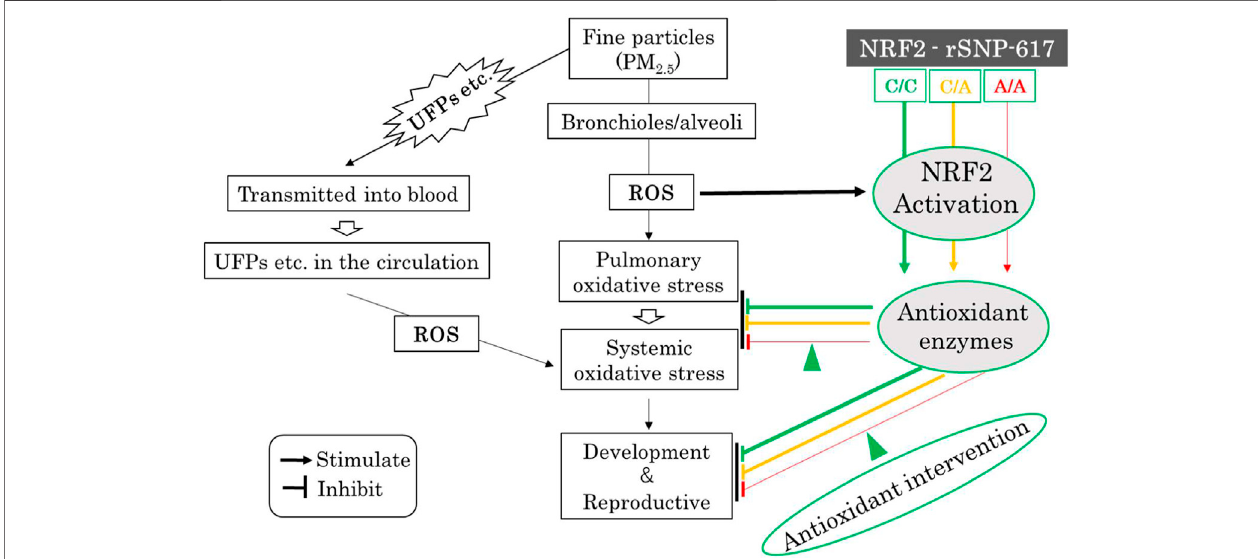
FIGURE 2 | Hypothesis schematic diagram of the potential NRF2 pathways to prevent developmental and reproductive toxicity of fi ne particles. The colored lines show the putative NRF2 signaling pathway, with the signals being weaker in the order green, orange, and red. ROS: reactive oxygen species, UFPs: ultra fi ne particles, C/C: wild-type homozygous (c. – 617C/C) alleles, C/A: SNP heterozygous (c. – 617C/A) alleles, A/A: SNP homozygous (c. – 617A/A) alleles; Green arrowhead: antioxidant intervention (NRF2-activating compounds, etc.).